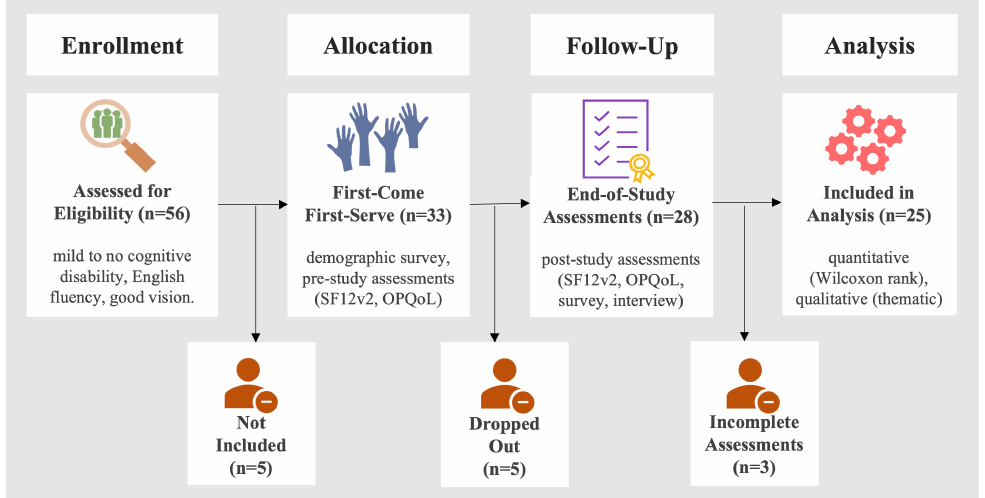
Figure 1. Participant flow